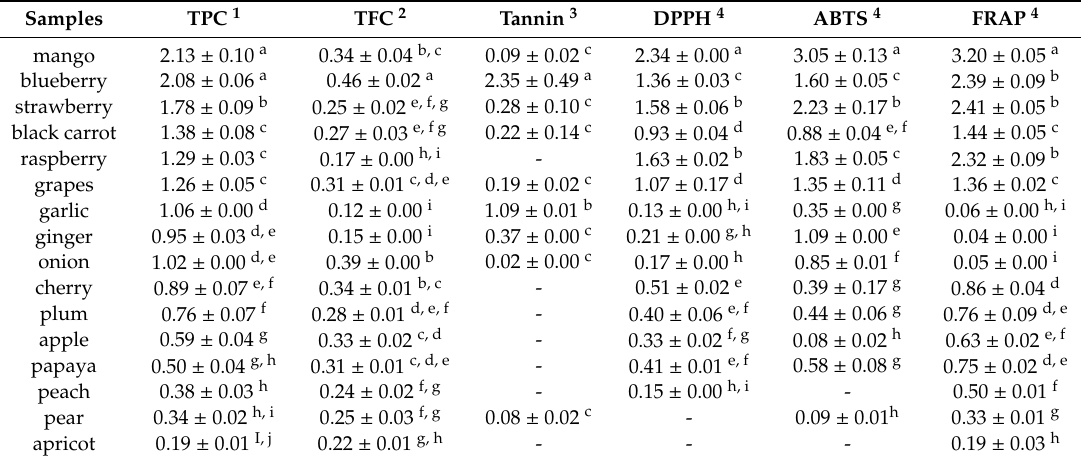
Table 1. Antioxidant potential of selected fruits and